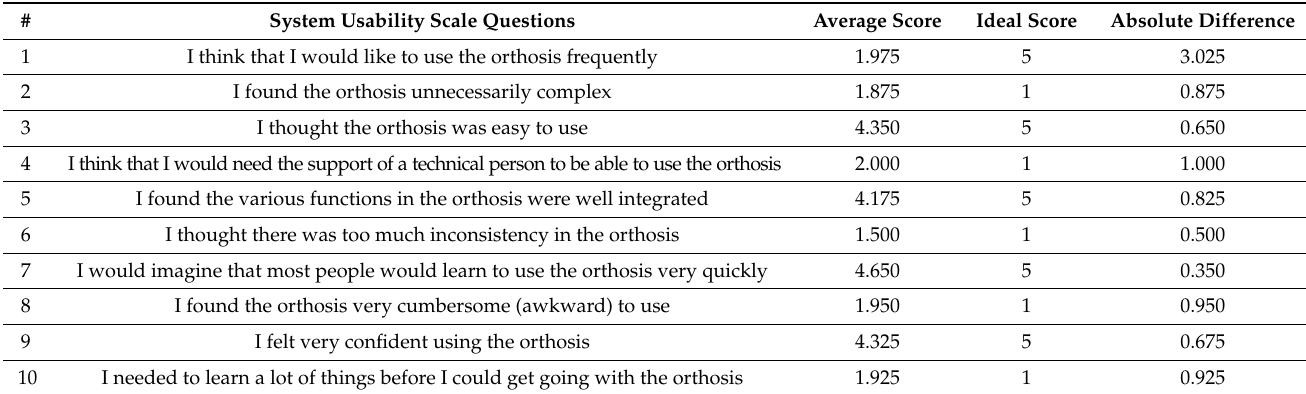
Table 2. SUS questions and average scores ( n = 40). Each question was scored on Likert scale from 1 to 5. Questions regarding positive aspects of CMPTO had ideal score of 5, while those regarding negative aspects of CMPTO had ideal score of 1. Absolute difference is found between average score and ideal